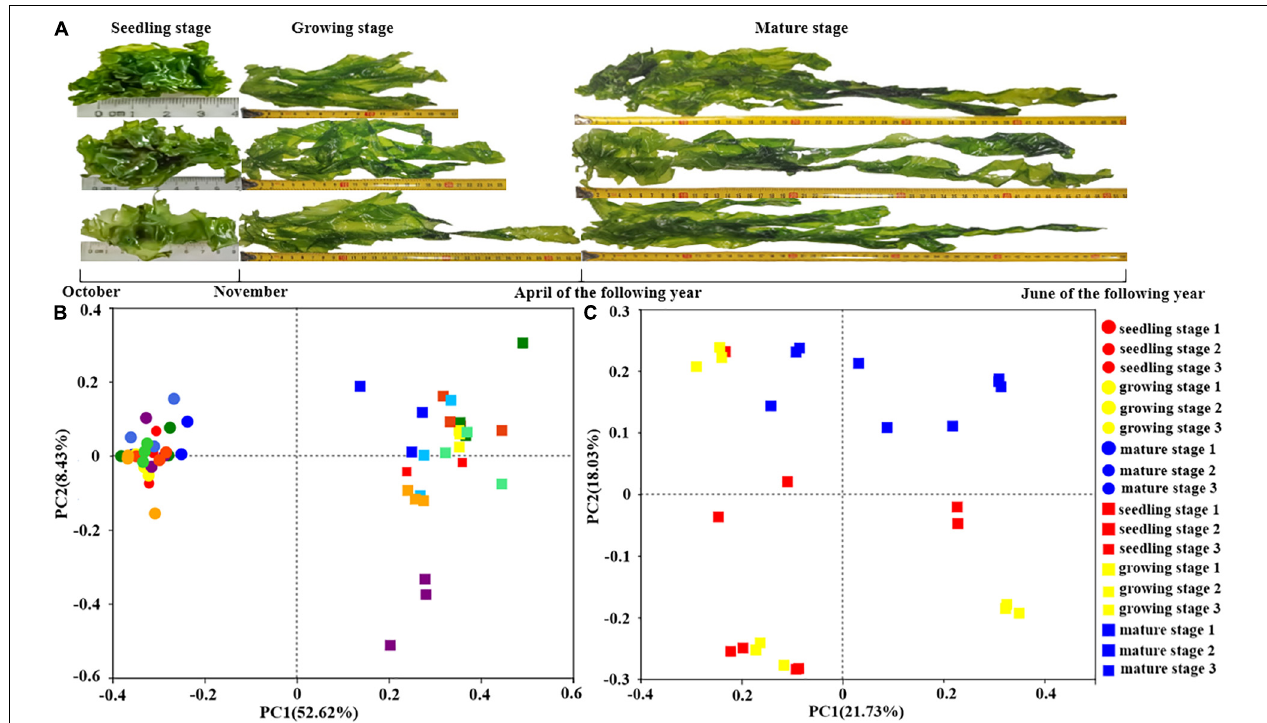
FIGURE 1 | The surface microbiota of Ulva fasciata variation at different growth stages. (A) Photographs of U. fasciata samples in different life cycles (B) Principal Coordinate Analysis of microbiota changes on the surface of U. fasciata and seawater samples of different growth stages at Genus Level (C) Principal coordinate analysis of microbiota changes on the surface of U. fasciata in different growth stages at Genus Level (the circles represent the seawater sample and the squares represent the surface of the U. fasciata